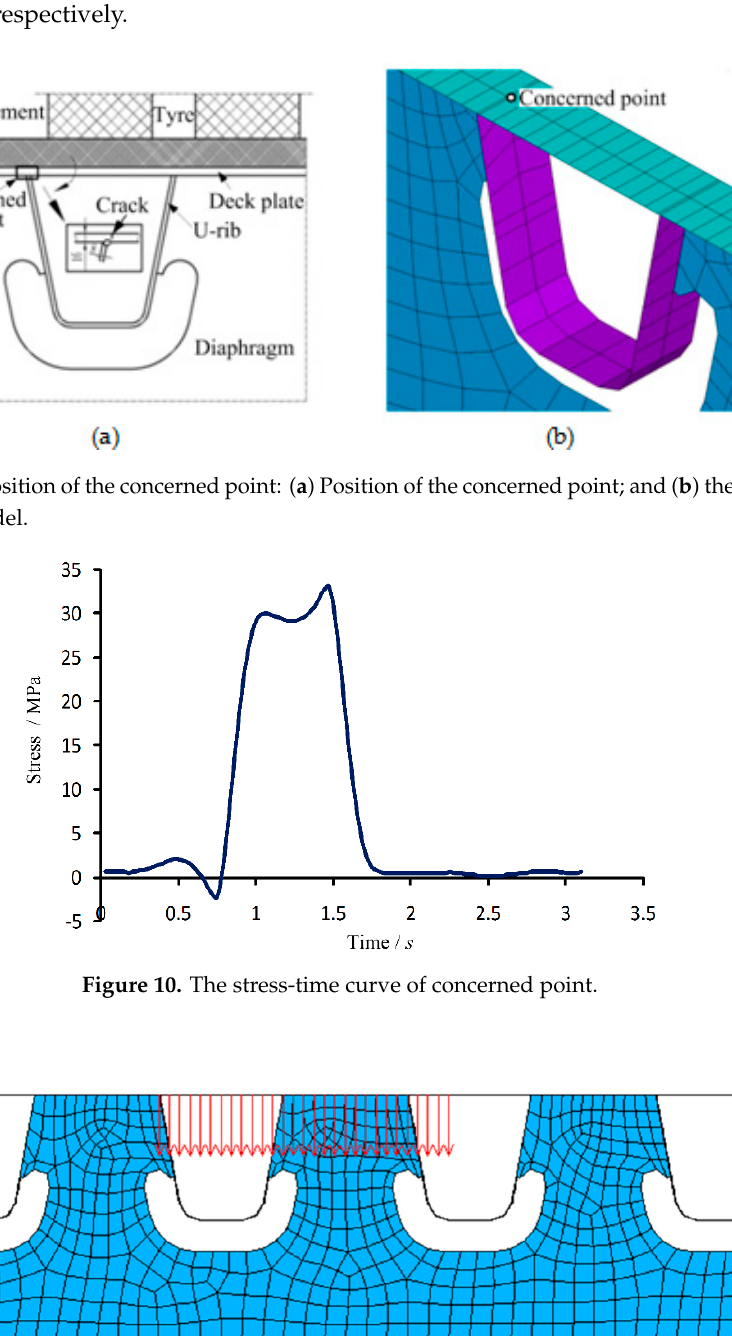
Figure 10. The stress-time curve of concerned point.